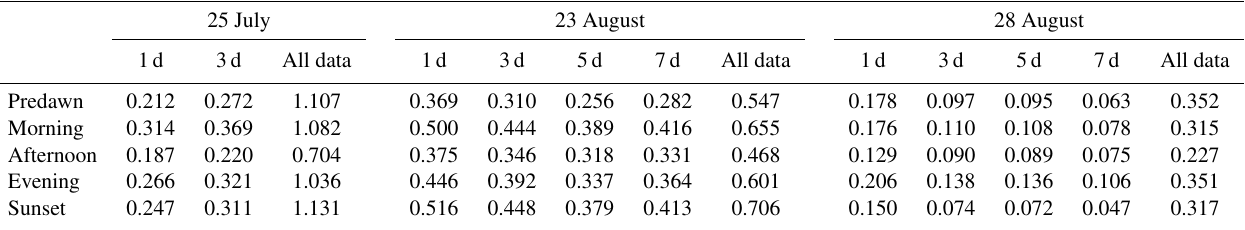
Table A1. Root mean squared error (RMSE) between reconstructed and sampled VWC. The rows represent time of constraining the recon- struction, while the columns represent the considered period for linear ET 0 correction.